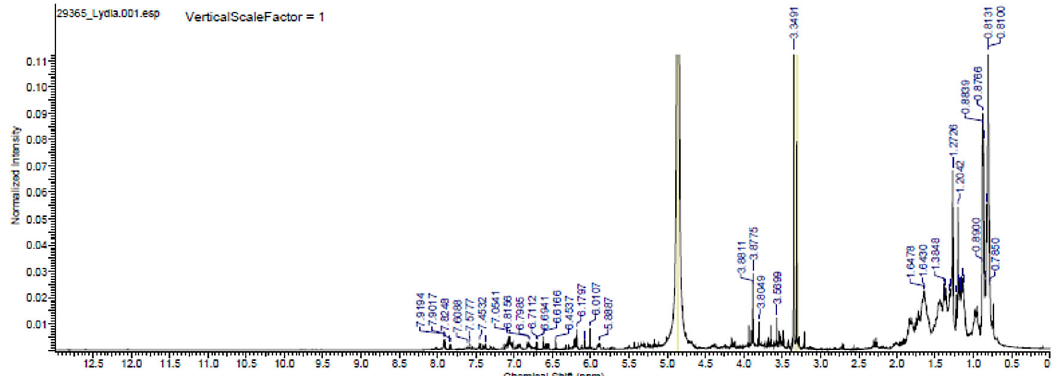
Figure 4. Proton nuclear magnetic resonance (NMR) spectrum (500 MHz, CD 3 OD, ppm ) of the methanolic fraction of Oxapampa propolis.